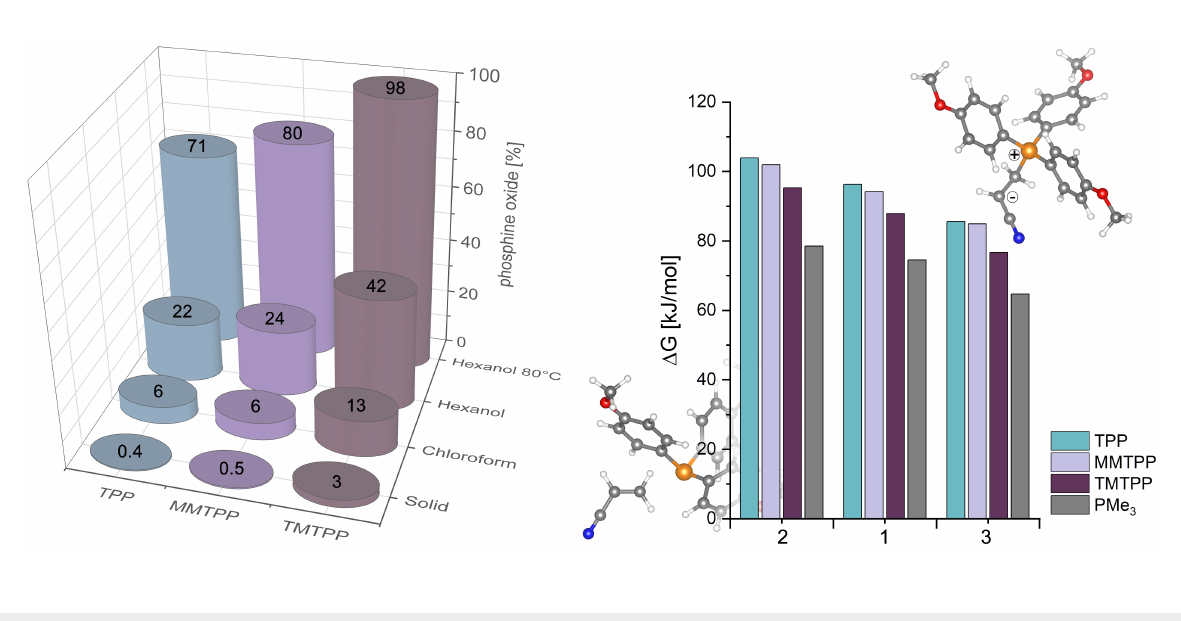
Figure 3: Left: Oxidation stability of the phosphines. Phosphine oxide content in % as determined by 31 P NMR spectroscopy after a 14 d exposure to air under the following conditions: sample stored as a solid at room temperature, samples dissolved in chloroform and 1-hexanol (stored at room tem- perature in the dark), and in 1-hexanol (stored at 80 °C in the dark). Right: Relative stabilities of the zwitterions formed upon reaction of Michael acceptors 1 – 3 with the phosphines (the cartoon shows the structures of the educts acrylonitrile and TMTPP (left, behind the chart) and the corre- sponding zwitterion (right, above), optimized at the B3LYP/def2-TZVPPD level of